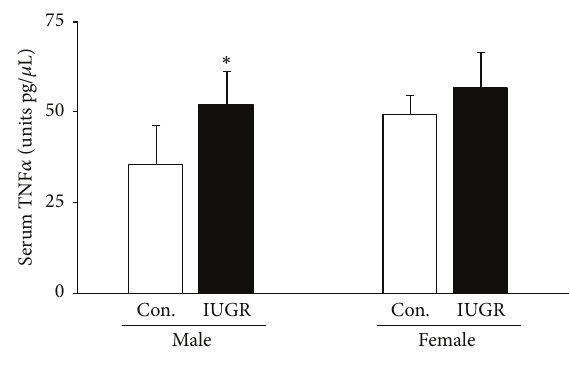
Figure 1: Serum TNF 𝛼 . IUGR increased serum TNF 𝛼 in male rats. Results are control (white bars) and IUGR (black bars). Errors are SD. 𝑛 = 6 , ∗ 𝑃 ≤ 0.05